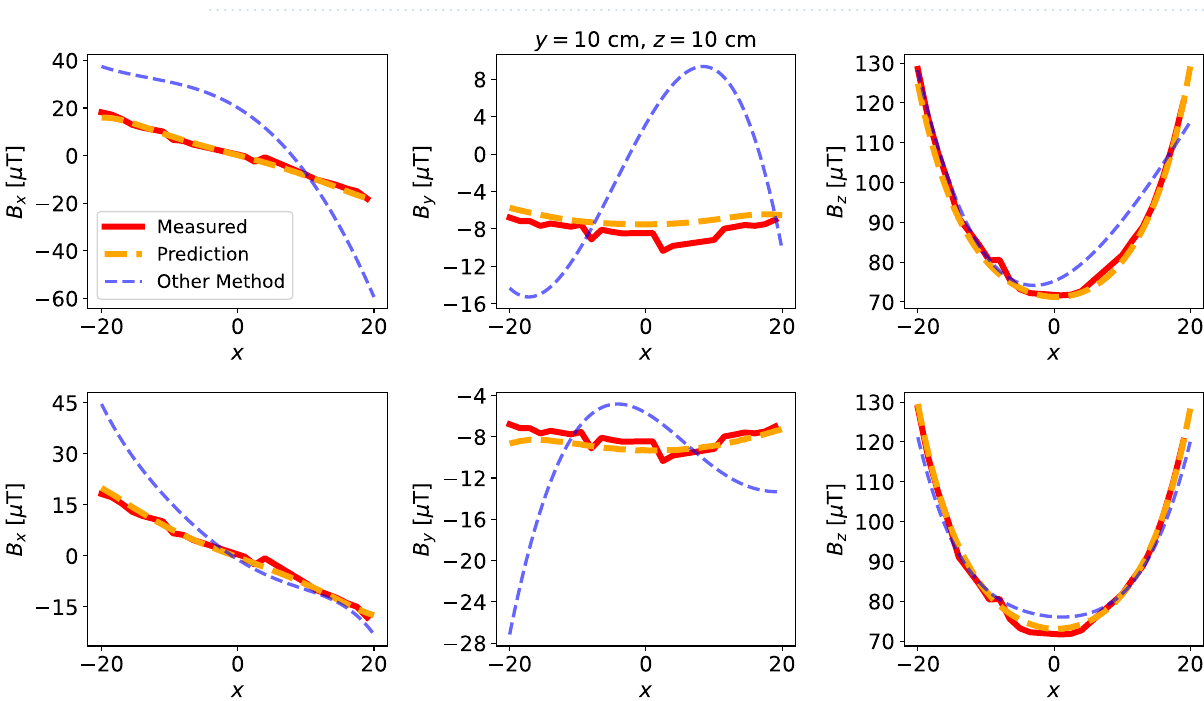
Figure 8. Comparison of the predicted and the other method’s solutions along y = 10 , z = 10 axis. Top: 18 sensor data, bottom: 30 sensor